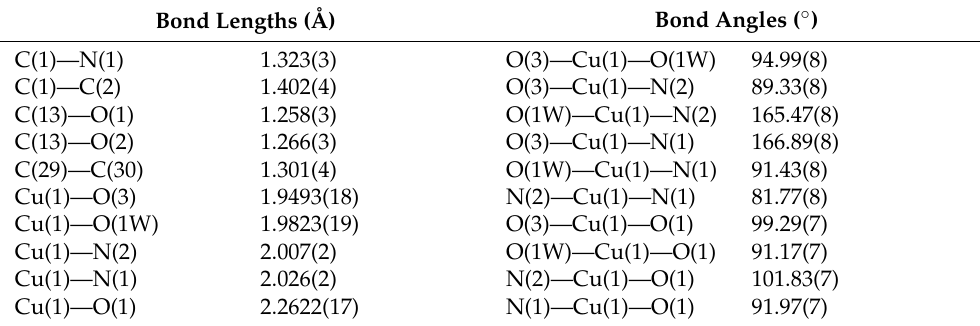
Table 2. Selected bond lengths [Å] and angles [ ◦ ] for the functional monomer [Cuphen(VBA) 2 H 2